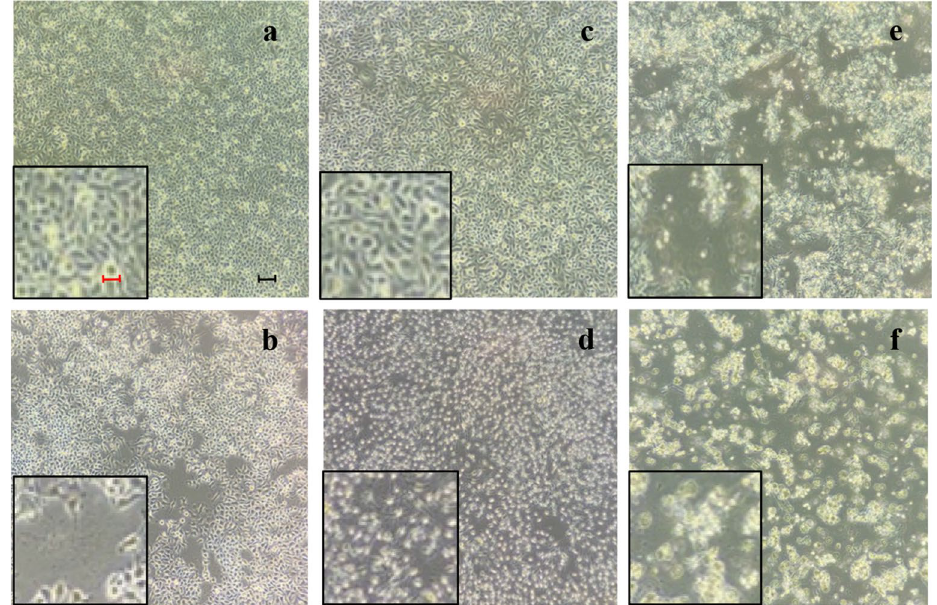
Figure 3. Microscopic observations of HepG-2 cell morphology after 72 h from treatment with: ( a ) DMSO vehicle only, the cells are all well attached and appear with their physiological morphology; ( b ) 5-AzaC positive control, cells still adhering to the substrate appear however bubbled and partially detached; ( c ) VF20, cells appear similar to cells with DMSO only; ( d ) VF200, cells appear contracted; ( e ) B33, cells still adhering to the substrate appear suffering and many cells lose adhesion to the substrate; ( f ) B75 treatment induce the detachment of cells from the substrate. Every picture reports a 5 × magnification on the left for a better image evaluation. Black bar represents 10 µm, the red one, 50